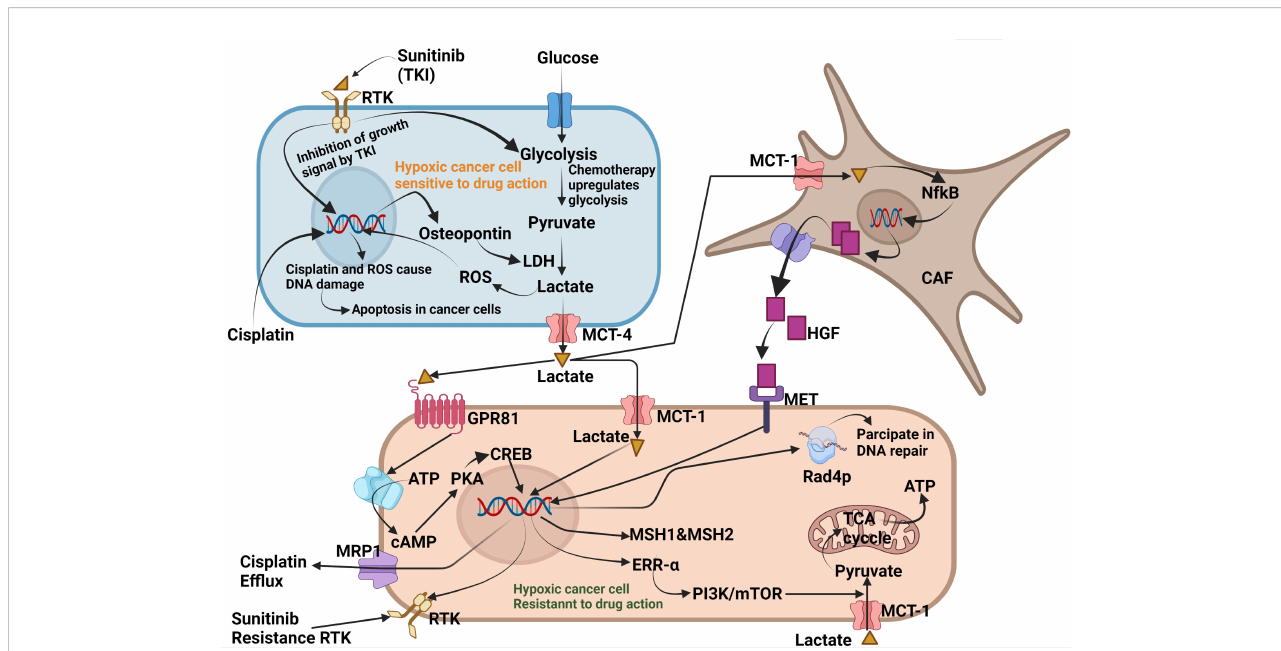
FIGURE 3 Molecular mechanism exploited by Lactate for developing resistance against chemotherapy. Exposure to cisplatin and tyrosine kinase inhibitors enhances cytoplasmic levels of osteopontin in cancer cells. Osteopontin enhances LDH expression which enhances glucose fermentation into lactate. Lactate from sensitive cancer cells is secreted into the TME via MCT4, where it is taken up by neighbouring cancer cells and cancer-associated fi broblasts (CAF). In lactate, NF- k B which enters the DNA, enhances the synthesis and secretion of the cytokine HGF. HGF from the TME binds to the MET receptor present on neighbouring cancer cells, making the receptor insensitive to tyrosine kinase inhibitors such as sunitinib. Lactate can also bind to GPR81 which enhances the expression of DNA mismatch repair proteins, such as MSH1 and MSH2, through the GPR81-cAMP-PKA-CREB axis. Cisplatin enhances cytoplasmic levels of oestrogen response receptor- a (ERR a ), which helps cancer cells utilise lactate as an energy substrate. Lactate also phosphorylates Rad4p, which participates in the repair of cisplatin-induced DNA damage and ROS. Created by